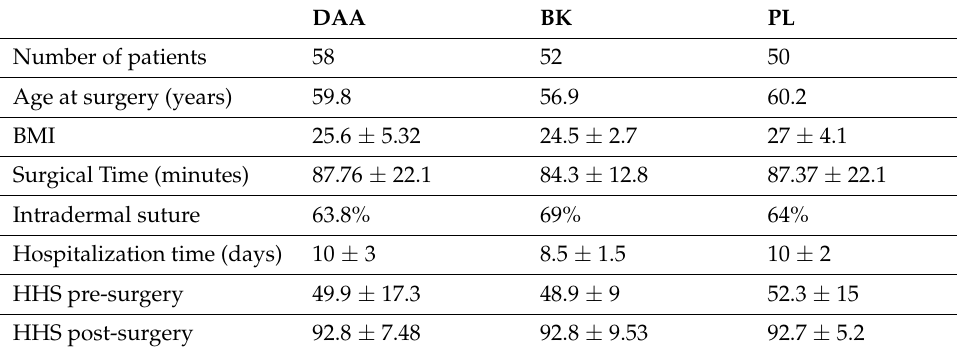
Table 1. Patient’s demographic, surgical and functional characteristics.